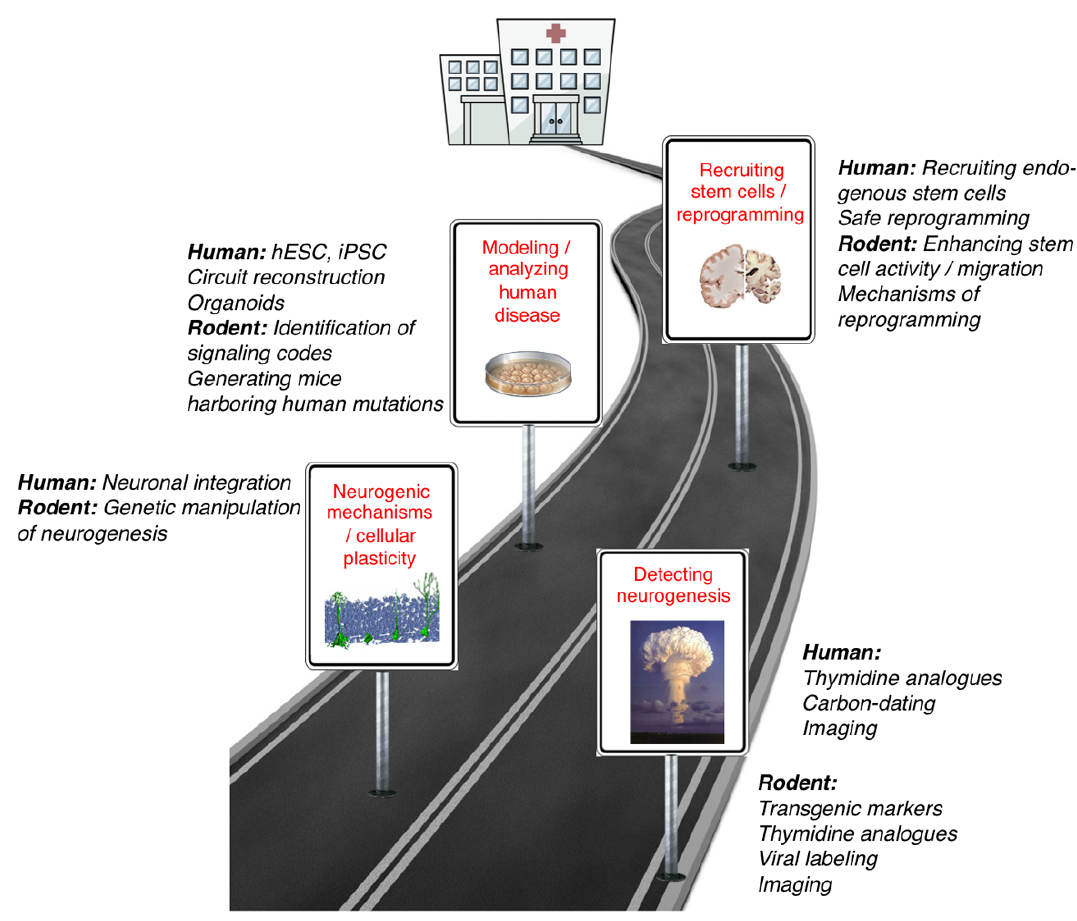
Figure 1. Road to harnessing stem cells and reprogramming strategies for neural repair. Future experiments will relate basic research findings obtained mostly in laboratory animals to the analyses of human disease and eventually to the therapeutic targeting of endogenous neural stem cells, the improved use of transplantation-based cell replacement strategies, or the reprogramming of other neural cells with the aim to enhance the potential for repair of the adult human brain. The road toward translation may lead from understanding physiologic and disease-associated neurogenesis in humans and an improved understanding of the molecular and cellular mechanisms underlying the neurogenic process toward novel approaches to study human diseases in the dish and mouse models. Finally, the application of this knowledge may lead to enhanced recruitment of endogenous stem cells or improved functionality of transplants and reprogramming-based approaches for neural repair. hESC, human embryonic stem cell; iPSC, induced pluripotent stem